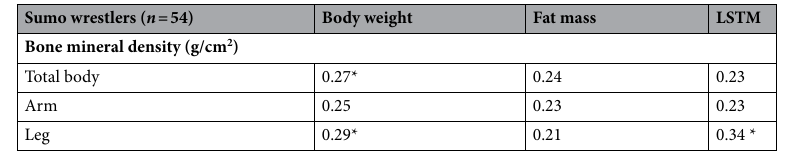
Table 3. Correlation coefficients between bone mineral density and body composition parameters. * p < 0.05. LSTM: lean soft tissue